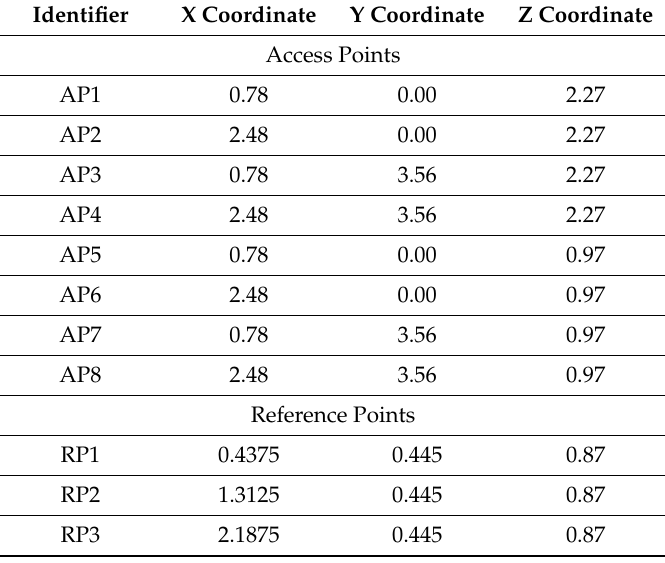
Table 1. Coordinates of access points (APs) and reference points (RPs).